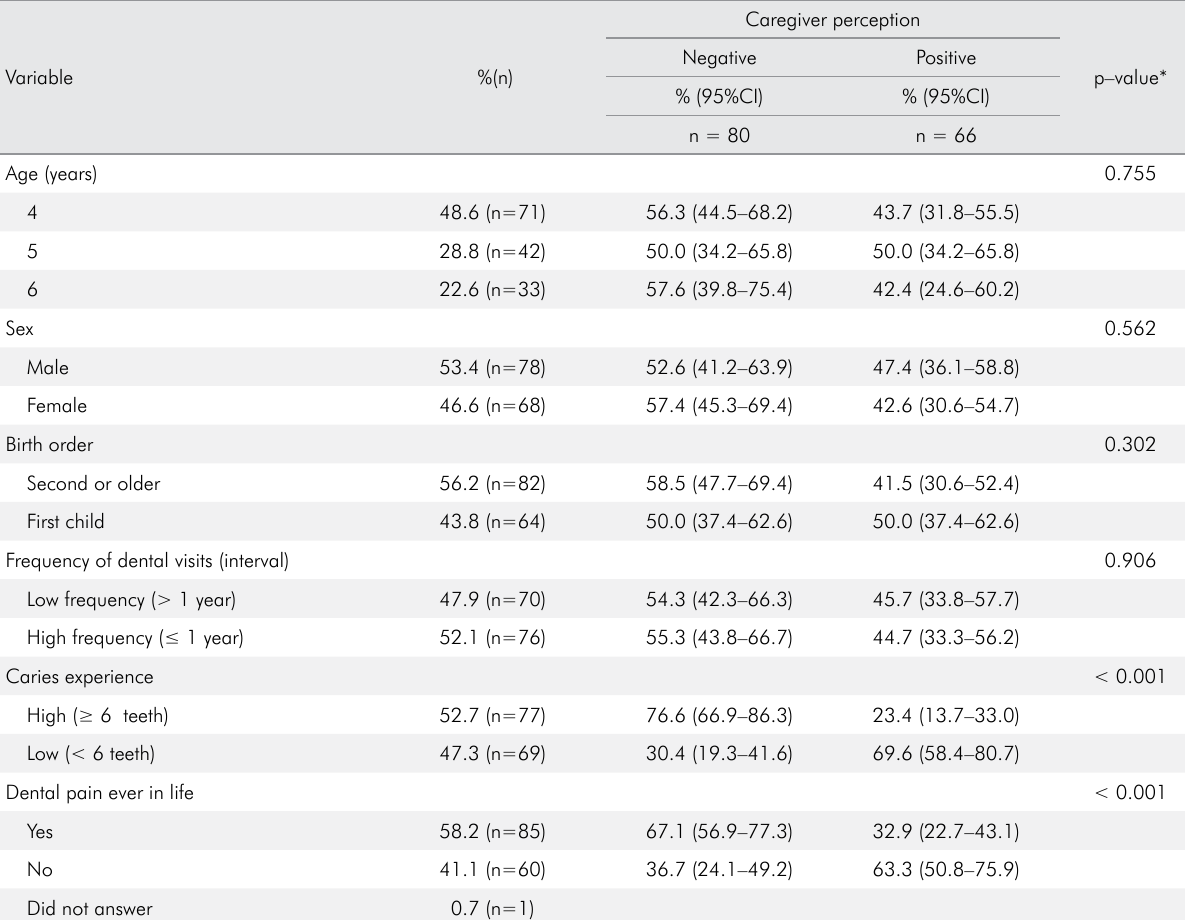
Table 2. Frequency distribution and bivariate analysis of the association between caregivers’ perception of children’s dental health and children–related independent variables (n =